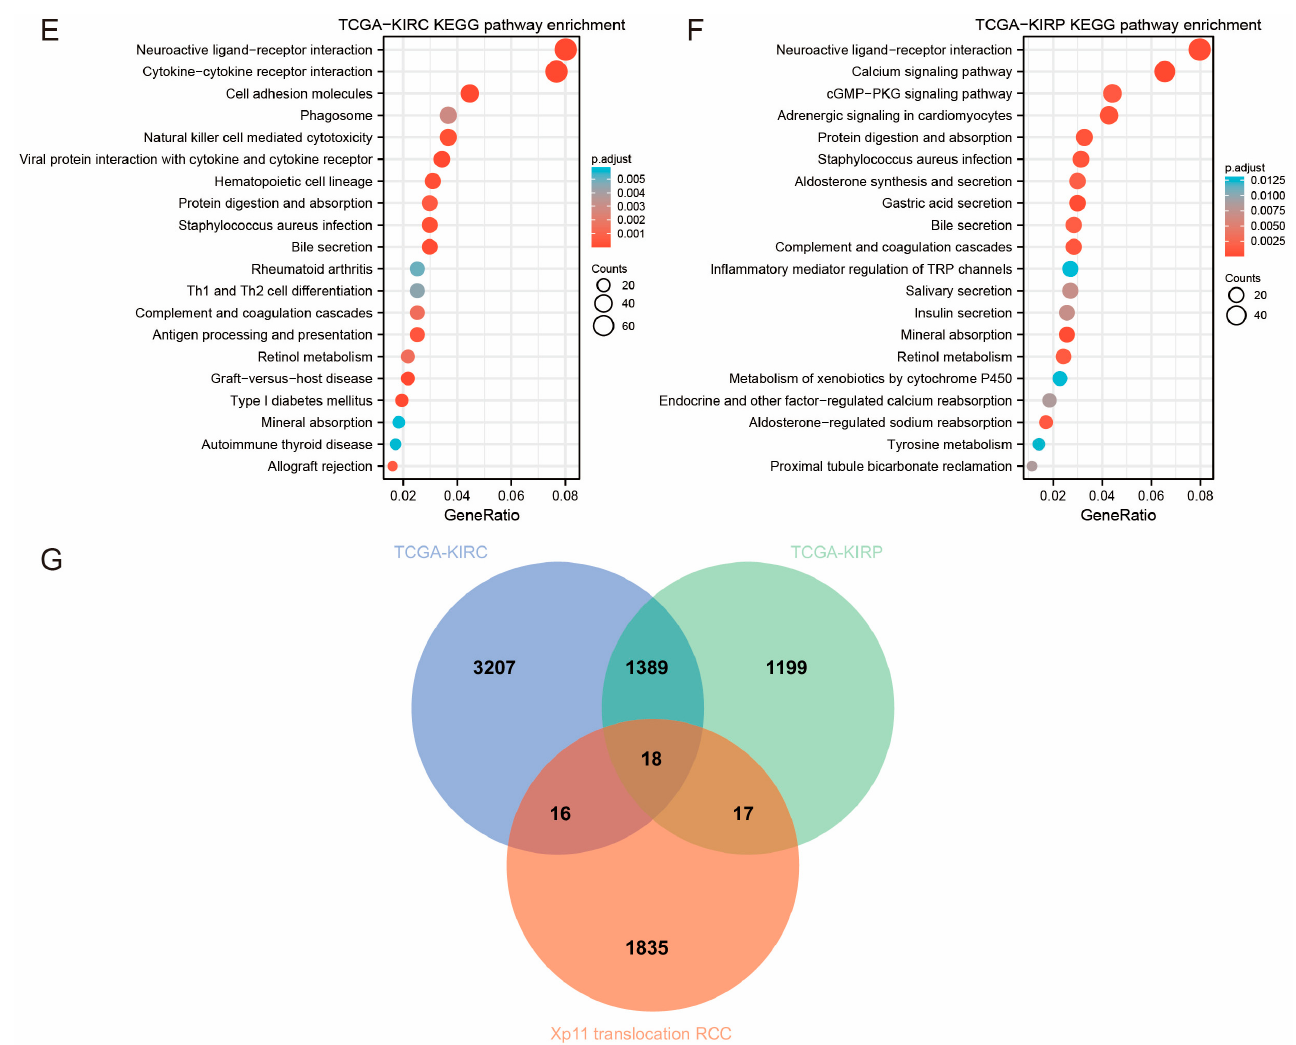
Figure 2. ( A ) Volcano maps of TCGA-KIRC. ( B ) Volcano maps of TCGA-KIRP. The red color represents upregulation, and the blue color represents downregulation. ( C , D ) Top 12 GO enrichment terms of TCGA-KIRC ( C ) and TCGA-KIRP ( D ). ( E , F ) Top 20 KEGG enrichment pathway of TCGA-KIRC ( E ) and TCGA-KIRP ( F ). ( G ) Venn plot of DEmRNAs of Xp11 translocation RCC, TCGA-KIRC, and TCGA-KIRP.